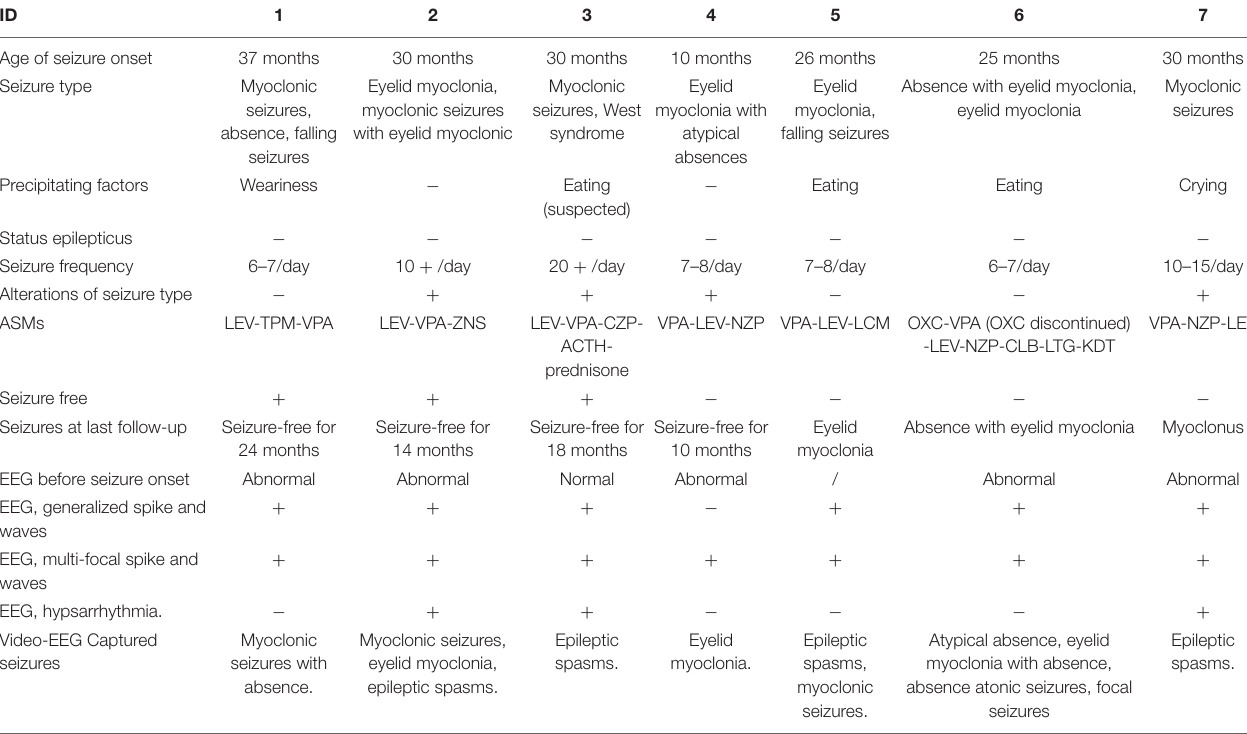
TABLE 3 | Epilepsy characteristics of seven patients.